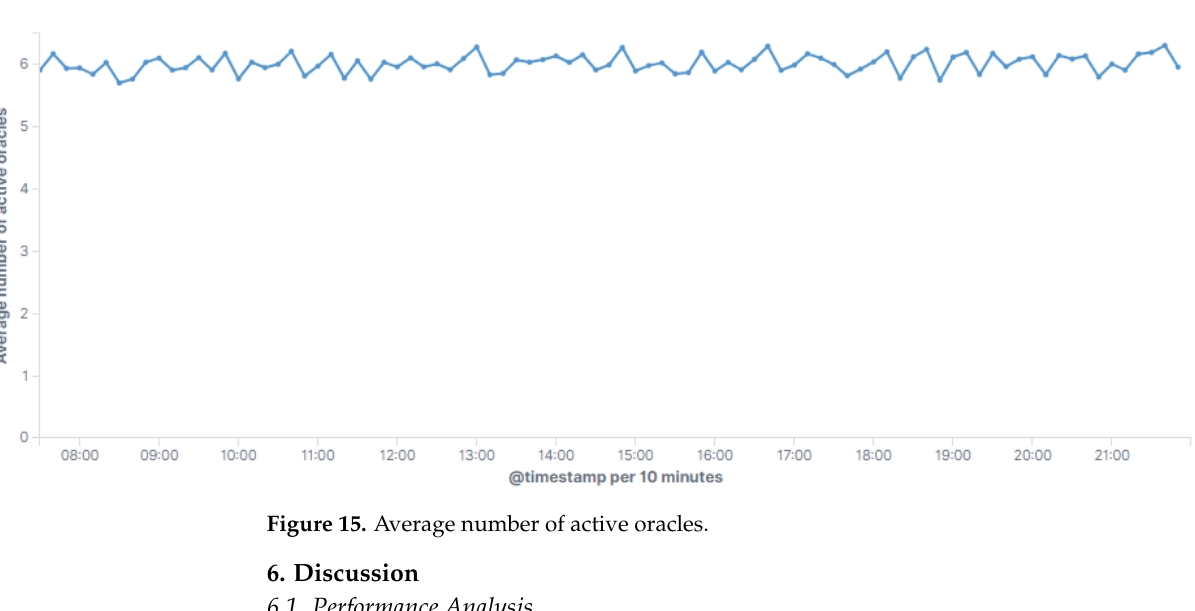
Figure 15. Average number of active